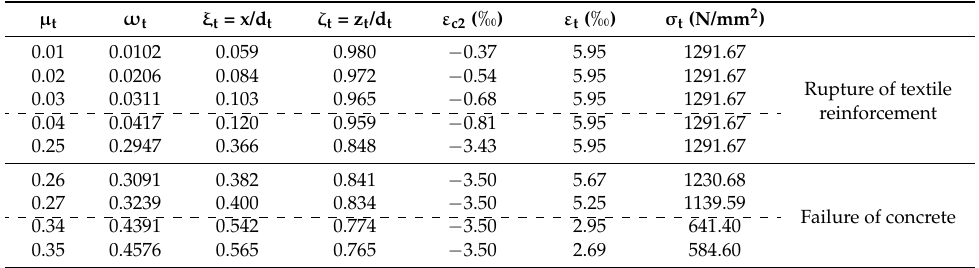
Table 2. Dimensionless design table for rectangular reinforced concrete RC member flexurally strengthened with textile reinforced concrete (TRC 1